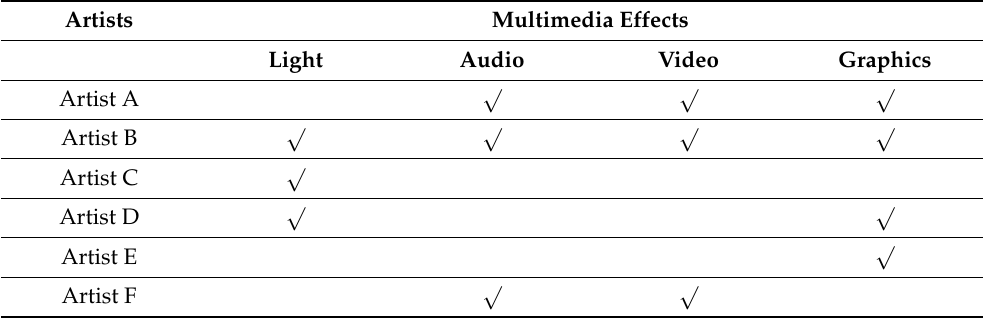
Table 5. The use of multimedia effects in sculpture as understood by multimedia sculpture